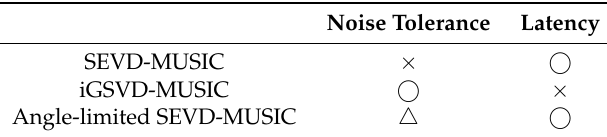
Table 2. Pros and cons of SEVD-MUSIC, iGSVD-MUSIC and angle-limited